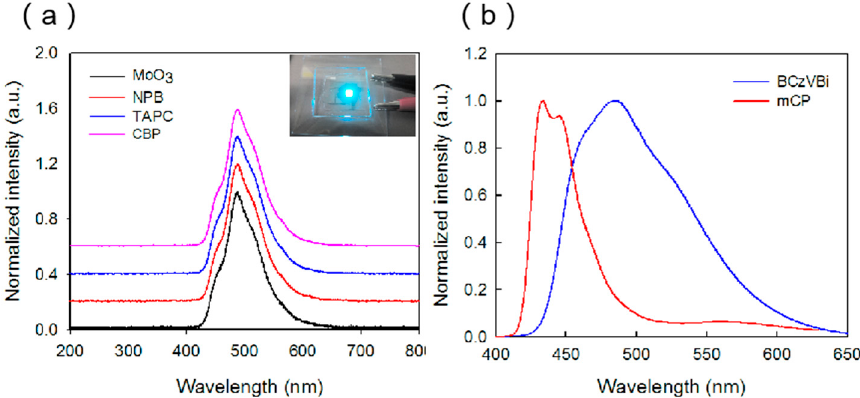
Figure 3. ( a ) Normalized electroluminescence spectra of OLEDs with TPBi ETL and four different HTLs. The inset is a luminescence image of the TAPC device at 50 mA / cm 2 . ( b ) Photoluminescence (PL) spectra of 30 nm mCP and BCzVBi films deposited on ITO substrates.